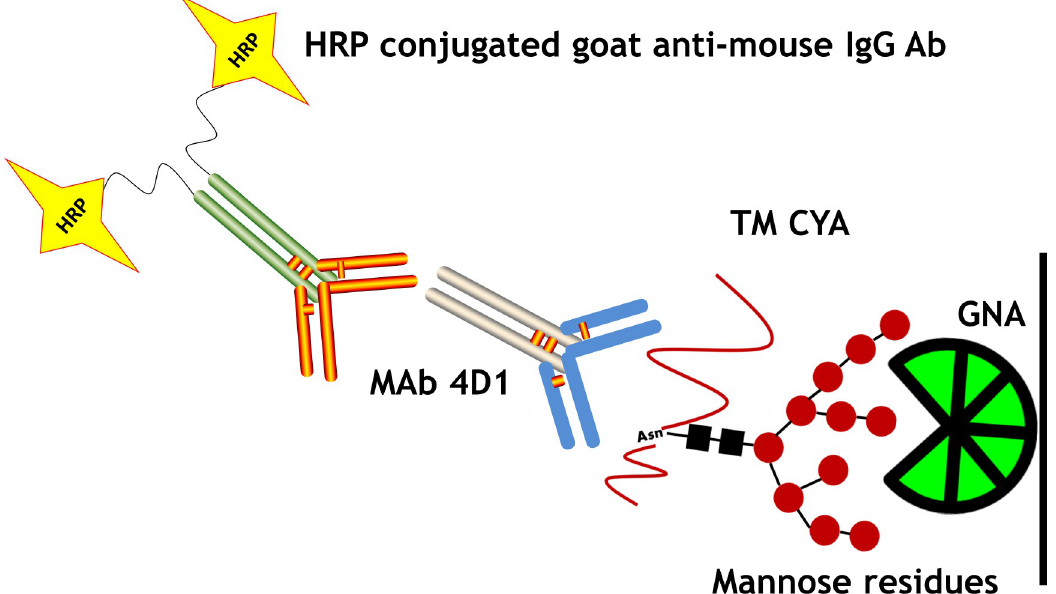
Fig 1. A schematic diagram of interactions between the carbohydrate binding lectin GNA, MAb 4D1 and TM CYA in the sandwich ELISA. The yeast phase-specific MAb4D1 was employed to recognize the core peptide epitope of TM CYA while the mannose-binding lectin ( Galanthus nivalis agglutinin, GNA), recognized the terminal mannose residues of TM CYA.